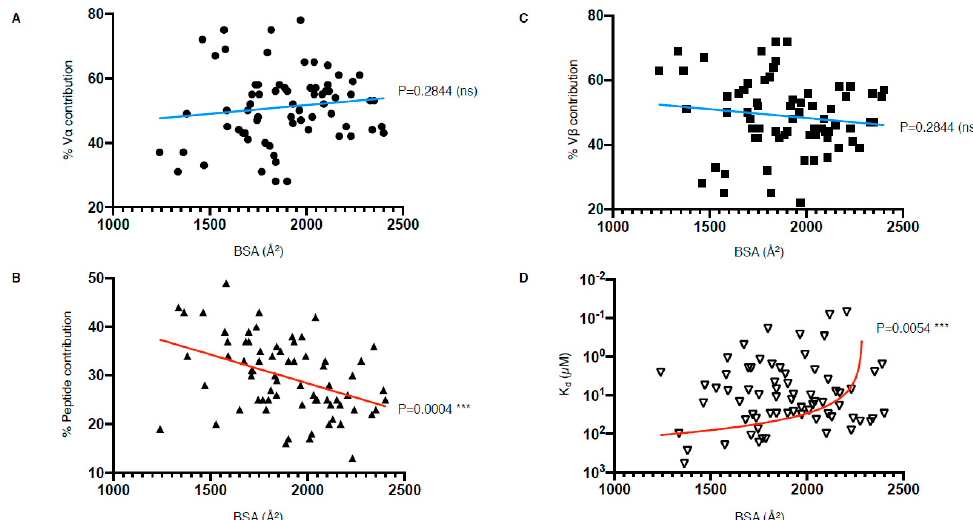
Figure 6. TCR–pMHC-I structural and biophysical parameter correlation. ( A – D ) Correlation between buried surface area (BSA); contribution from the V α , V β , or peptide; as well as affinity (Kd) were assessed using simple linear regression calculated with Prism 8 ( p ≤ 0.05 is considered as significant, ns: p > 0.05 ***: p ≤ 0.001). Derived function is coloured red if the correlation is significant and blue if not significant. The TCR–pMHC-I complexes without reported affinity (NA in Table 1) were removed as well as the engineered high affinity MAG-IC3 TCR to keep only naturally occurring TCR.